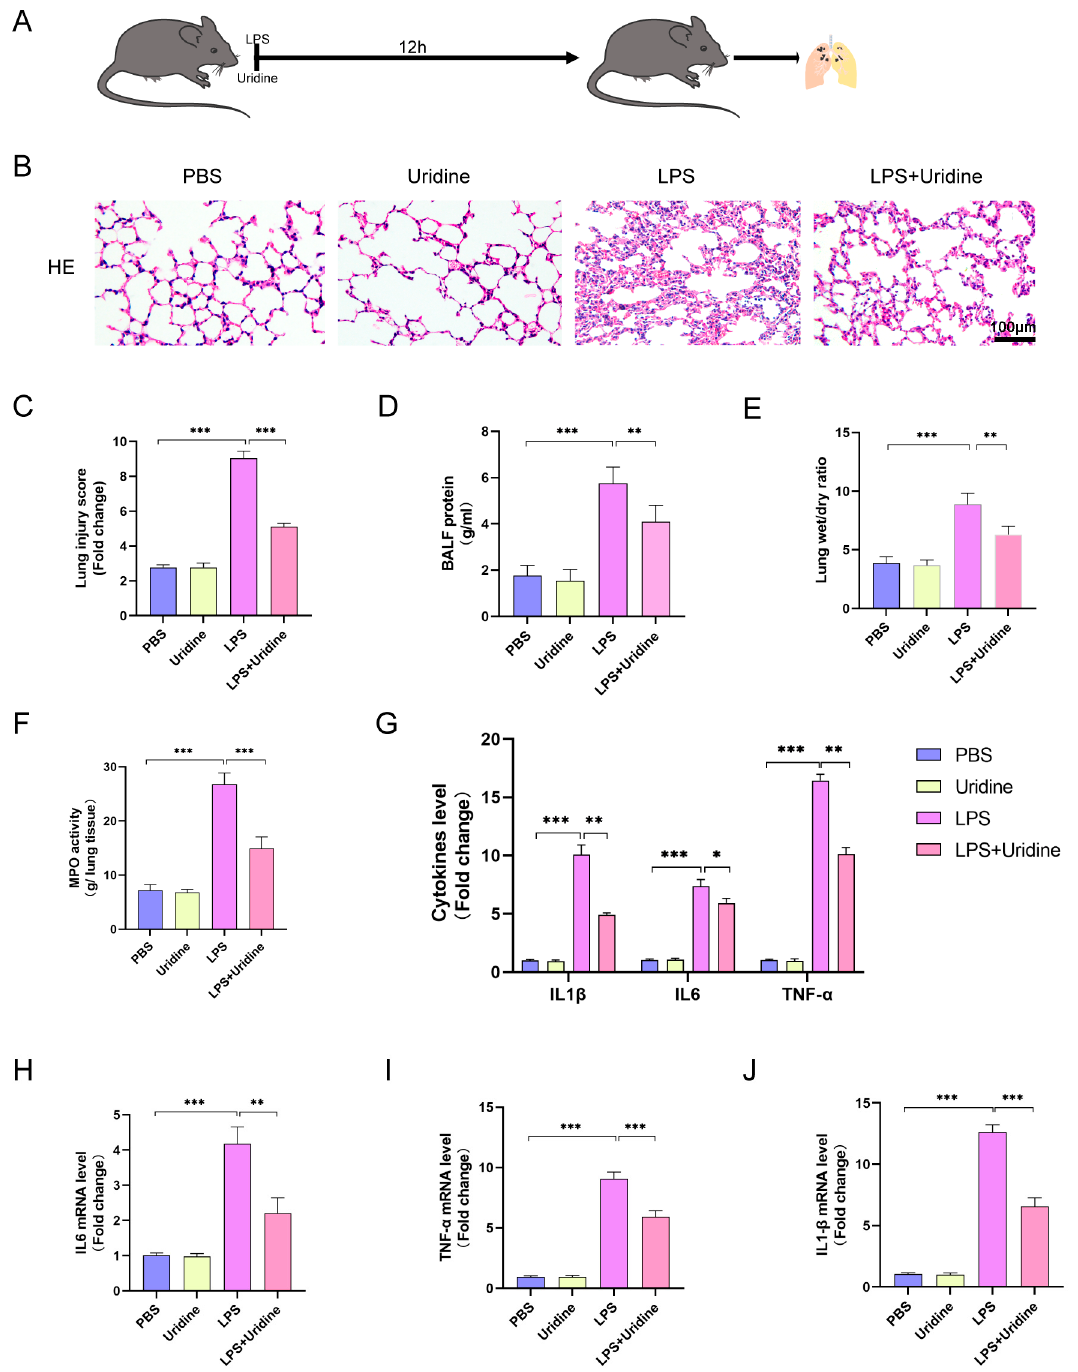
Figure 2. Uridine supplementation significantly attenuated sepsis-induced ALI in vivo. ( A ) Schematic diagram of animal experiment. ( B , C ) Representative images of H&E staining of mouse lung tissue at 12 h after LPS injection and semiquantitative lung injury scores in groups were analyzed based on the pathological section results. ( D ) BALF protein level in the indicated group. ( E ) Lung wet-to-dry weight ratio was determined in the indicated group. ( F ) The myeloperoxidase (MPO) activity of lung tissue in the indicated group. ( G ) ELISA for IL1 β , IL6 and TNF α in lung tissue in the indicated group. ( H – J ). Relative mRNA levels of IL6, TNF α and IL1 β in lung tissue in the indicated group. n = 6 mice per group (Data are presented as Mean ± SD, * p < 0.05, ** p < 0.01, *** p < 0.001 compared with indicated group).